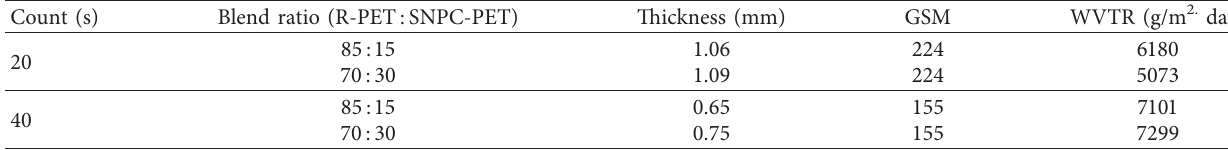
Table 8: The moisture vapor transmission rate (MVTR) of knitted fabric.